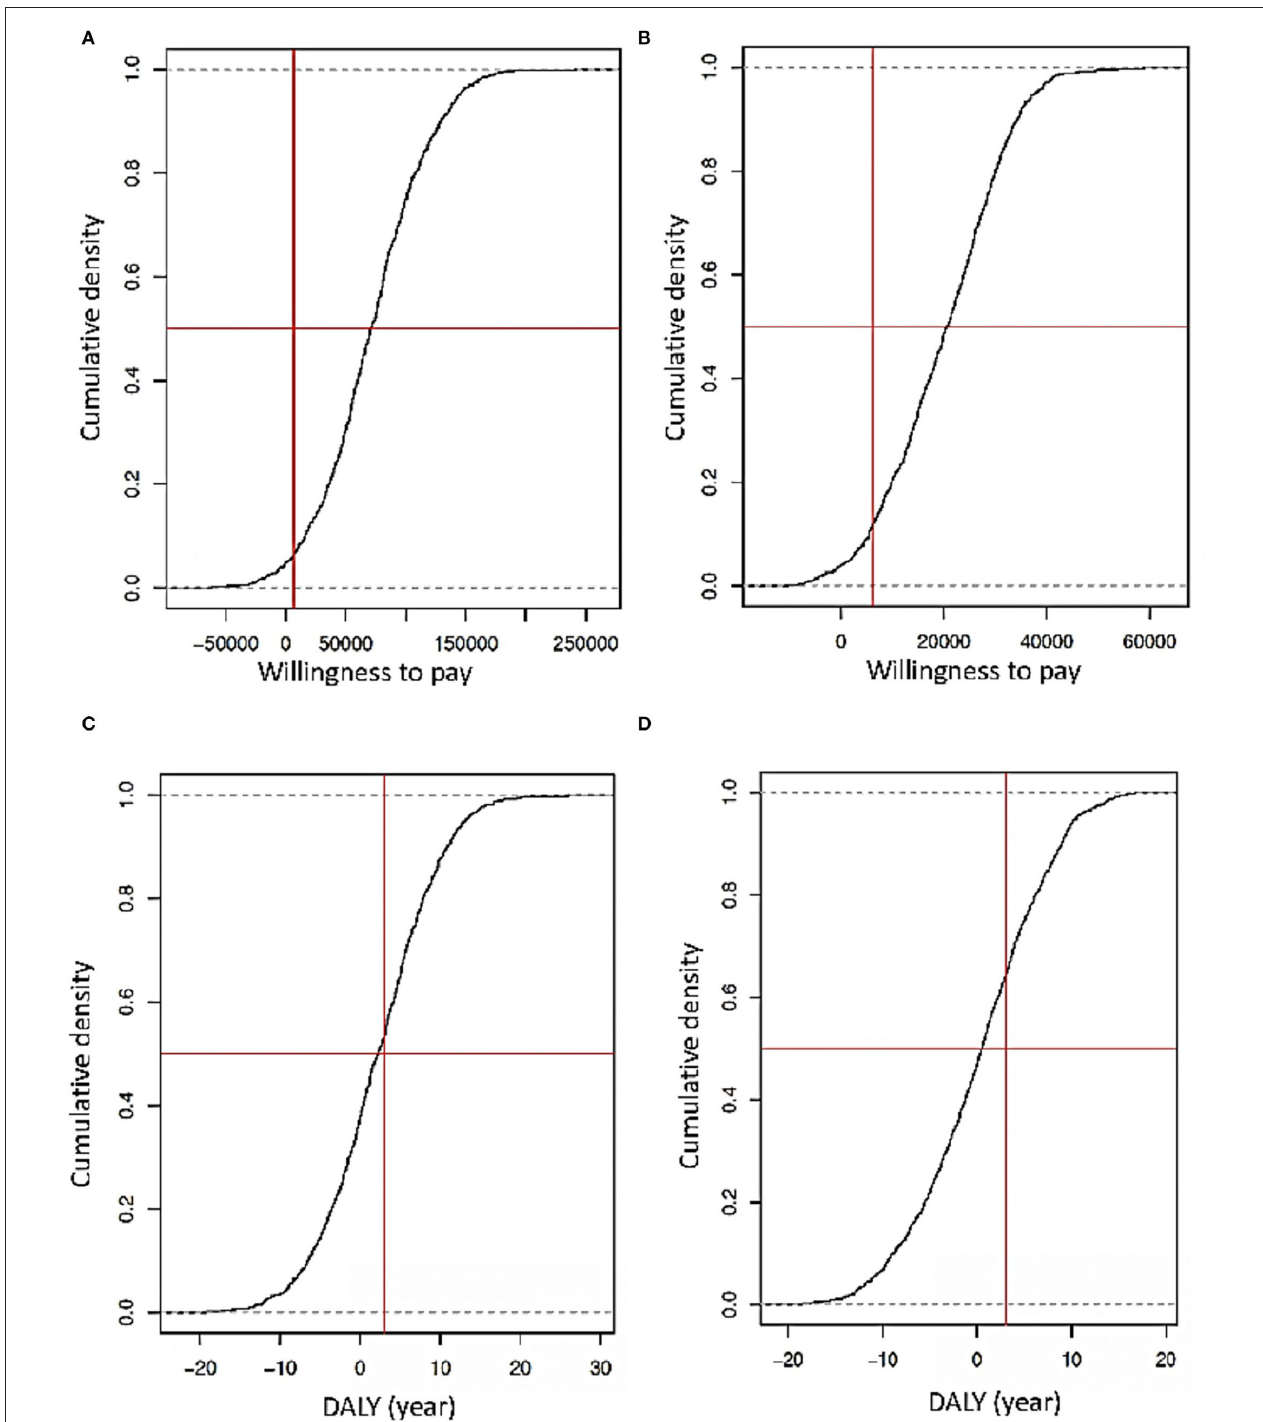
FIGURE 9 | (A) Simulation of DALY’s years’ loss or gain using deterministic data for the combination of ART and PrEP. (B) Simulations of DALY’s years gained or loss using stochastic data for the combination of ART and PrEP (the Y-axis is the probability that an expending would be accepted and forming part of the implementation strategy, X-axis represents how much a government can spend on a plan according to its GDP, represented by a vertical red line, and the horizontal red line is the logistic regression threshold of 50%). (C) Simulations of DALY’s years gained or loss using deterministic data for ART and PrEP. (D) Simulations of DALY’s years gained or loss using stochastic data for the combination of ART and PrEP (* the Y-axis is the probability of loss or gain years of life due to an implemented strategy. The vertical red line represents the standard DALYs lost by a later diagnosis, and the horizontal red line is the logistic regression threshold of 50%).